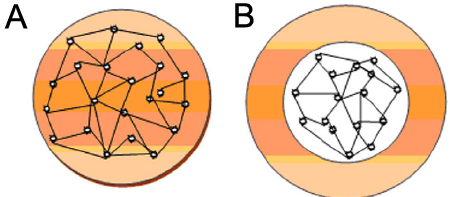
Figure 4. Schematic representation of polymeric nanoparticles: ( A ) nanospheres, ( B ) nanocapsules. Reprinted from Nanomedicine: Nanotechnology, Biology, and Medicine, 6, Mishra, B.; Patel, B.B.; Tiwari, S., Colloidal nanocarriers: a review on formulation technology, types and applications toward targeted drug delivery, 9–24 [30], Copyright (2010), with permission from Elsevier.